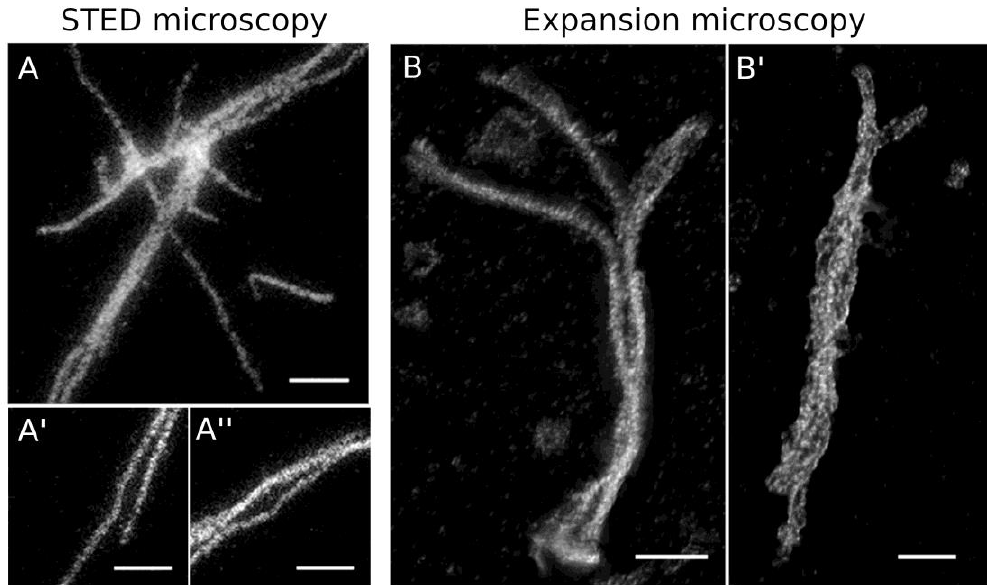
Figure 7. Super-resolution fluorescence microscopy of HisMyc-NE81ΔNLSΔCLIM filaments. ( A – A′′ ) stimulated emission depletion (STED) microscopy: assemblies formed at low protein concentration (5 µg/mL) were stained with anti-NE81/anti-rabbit-Atto 647N. Scale bars = 1 µm. ( B , B′ ) Expansion microscopy with deconvolution, 3.5-fold expanded; assemblies formed at 0.3 mg/mL ( B ) and 5 µg/mL ( B′ ) were stained with anti-NE81/anti-rabbit-AlexaFluor 488. Maximum-intensity projections are presented. Refer to supplemental videos 1 and 2 to get a three-dimensional impression. The scale bar (2 µm) refers to the original size of the specimen.